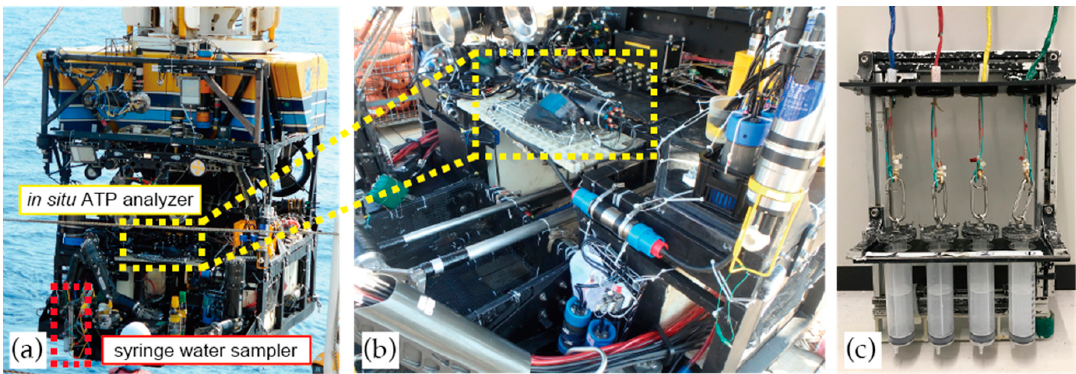
Figure 6. Remotely operated vehicle (ROV) HYPER-DOLPHIN with the in-situ ATP analyzer ( a ); Close-up view of the in-situ ATP analyzer mounted on the payload space of the ROV ( b ); The syringe water sampler ( c ).